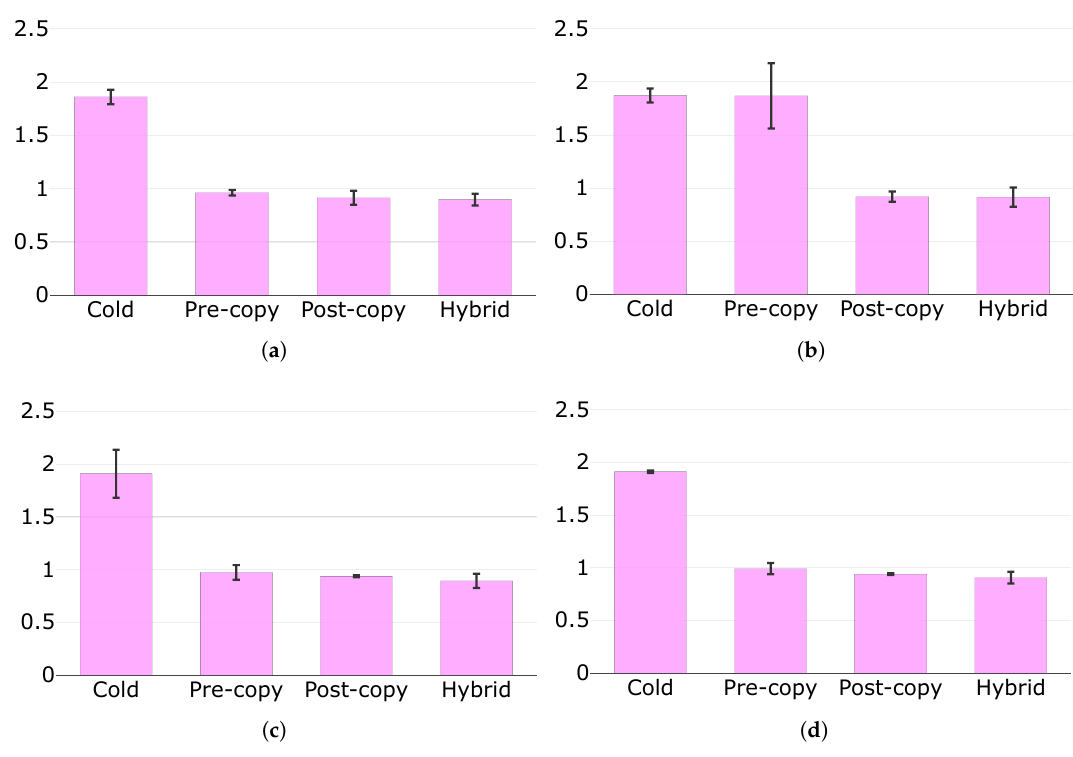
Figure 9. Dump times (s) under: ( a ) configuration A; ( b ) configuration B; ( c ) configuration C; and ( d ) configuration D.